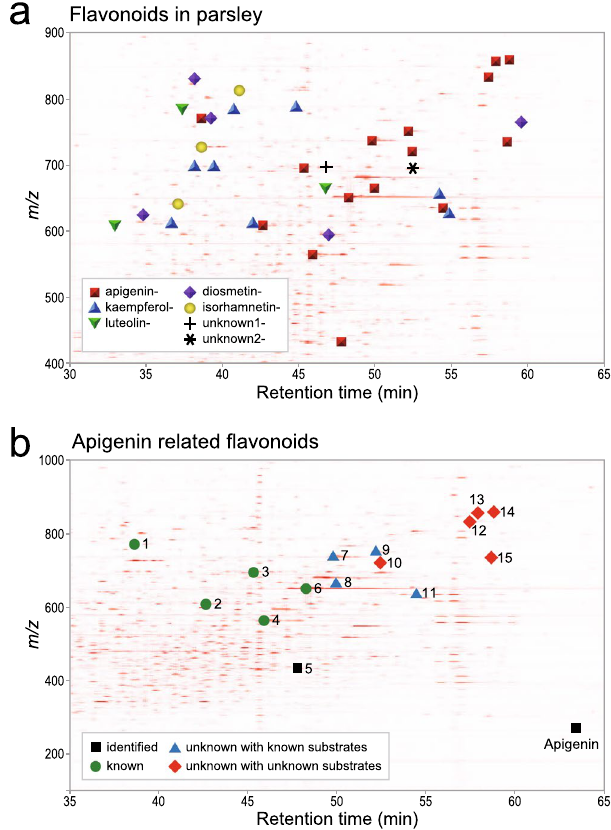
Figure 4. Flavonoids in parsley samples. ( a ) Flavonoids in parsley annotated by FlavonoidSearch (Jaccard index > 0.3) and manual curation. Peaks of derivatives of characteristic aglycones in parsley (apigenin derivatives, red squares; kaempferol derivatives, blue triangles; luteolin derivatives, green inverted triangles; diosmetin derivatives, purple diamonds and isorhamnetin derivatives, yellow circles) and two unknown aglycones (C 16 H 13 O 7 + , plus symbol; and C 17 H 15 O 6 + , asterisk) are represented on a two-dimensional (2D) mass chromatogram. The peak positions on an overall view of the 2D mass chromatogram is shown in Supplementary Fig. S4. (b) Apigenin-related compounds annotated in parsley. Peaks identified using authentic compounds (black squares), known derivatives (green circles), unknown derivatives with combinations of known O -substituents (blue triangles) and unknown derivatives with unknown substituents (red diamonds) are represented on a 2D mass chromatogram. The numbers correspond to the peak numbers shown in Supplementary Table